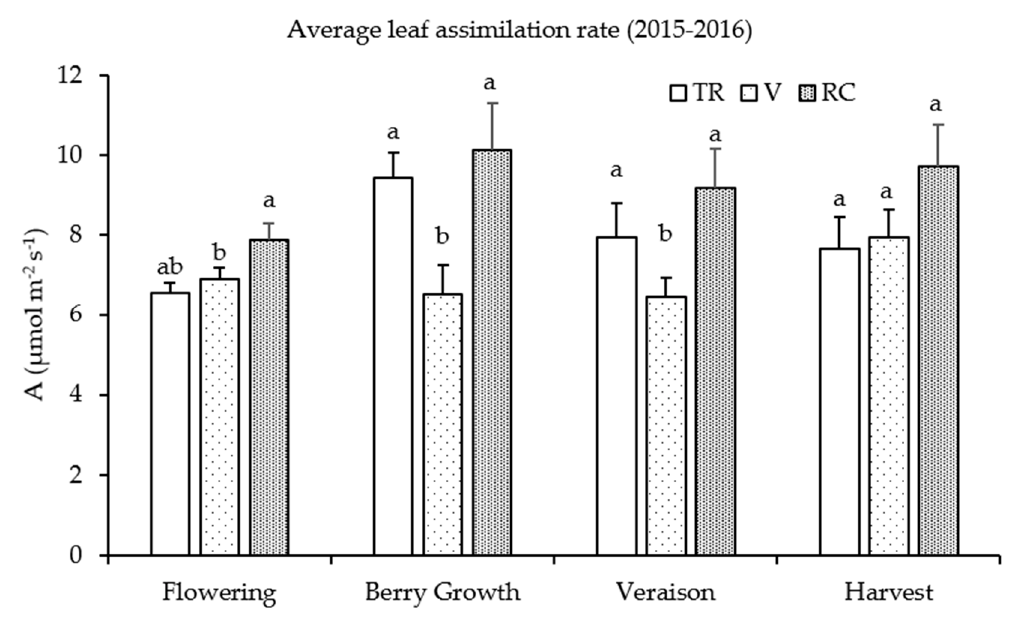
Figure 1. Soil management effects on leaf assimilation rate. (Different letters indicate statistical difference at p < 0.05; error bars indicate the standard error; n. of rep. 9). Note. TR = subterranean clover; V = common vetch; RC = roller crimper vetch.